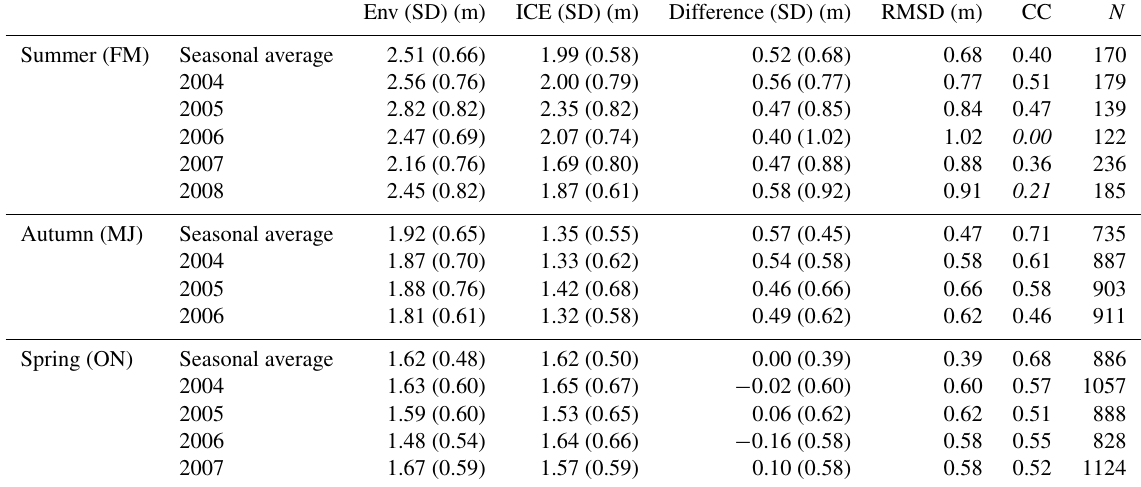
Table 5. Statistical results of the comparisons between Envisat sea ice thickness and ICESat sea ice thickness for each ICESat operating period. The correlation coefficients (CCs) in italic type have not passed the 95% significance test. N is the number of comparison